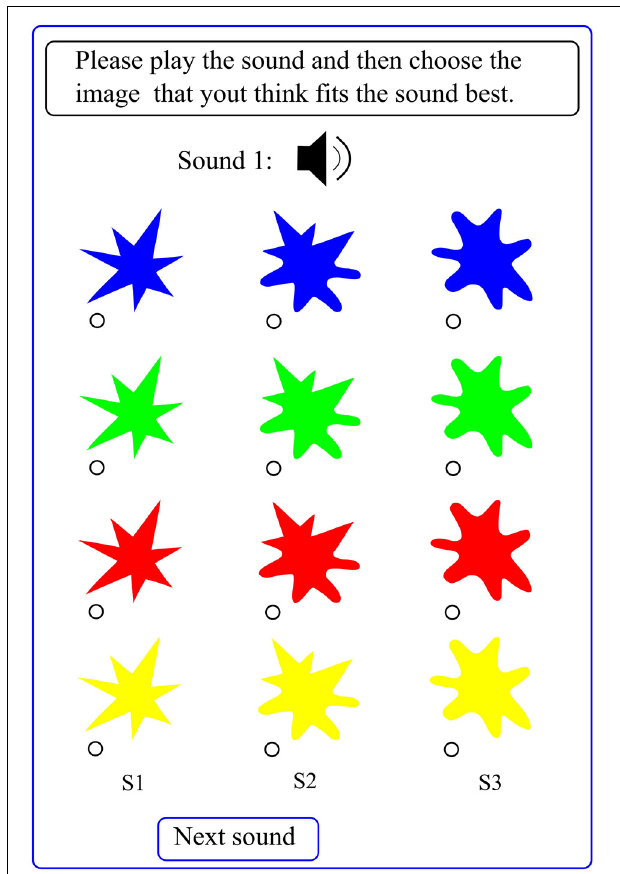
FIGURE 2 | The web interface designed for the experiment: each page includes 12 visual stimuli i.e., 3 shapes by either four colors (blue, green, red, and yellow) or four grayscales (0 (black), 0.3, 0.6, and 0.9). Each row has a different color (grayscale) which changes randomly. Subjects had to play the sound and select its visual equivalent. Whenever needed in this article, labels S1, S2, and S3 are used to refer to the three